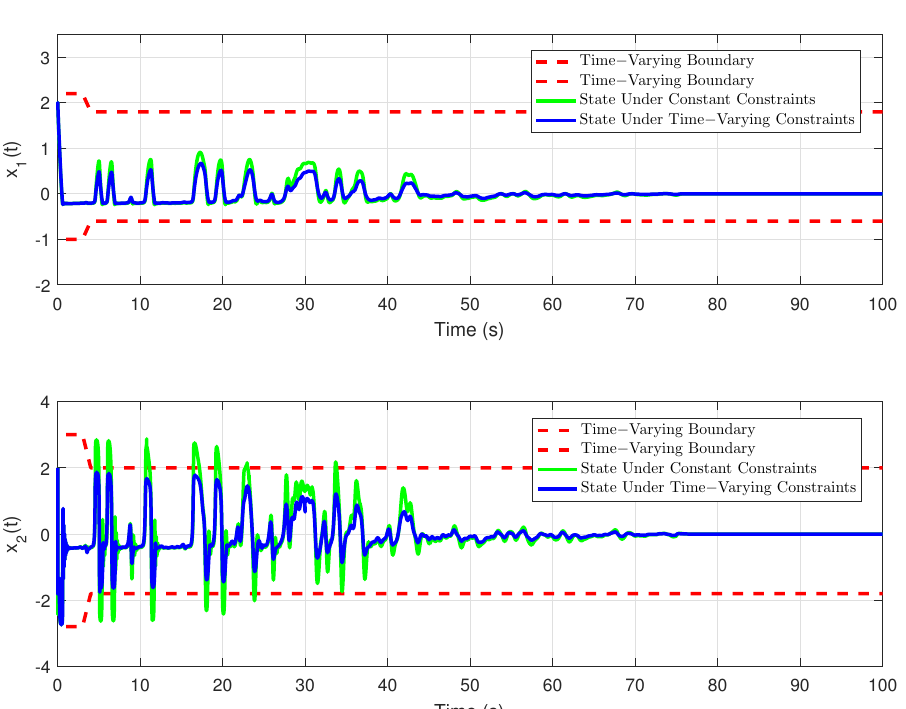
Figure 2. Evolution of the state x ( t ) by using the presented method and the method in [35].